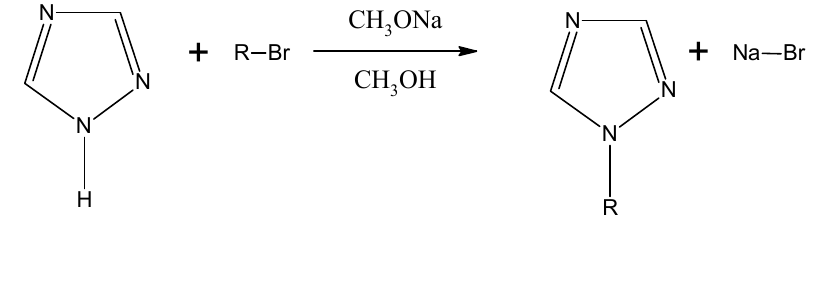
Figure 1. Scheme of alkylation reactions of triazoles with bromoalkanes.